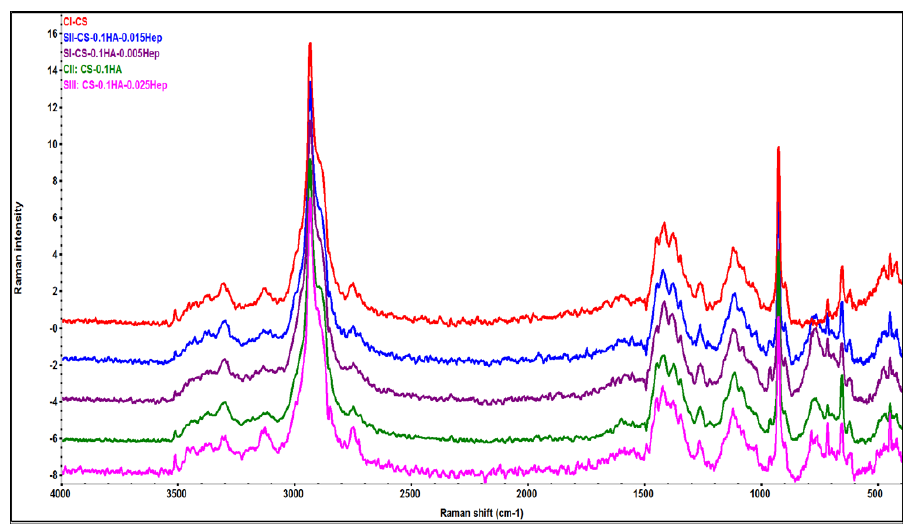
Figure 9. A comparison of FT-Raman spectra of all hydrogel samples obtained by mean of nine spectra from a square area mapping and baseline corrected and offset data in OMNIC TM software.